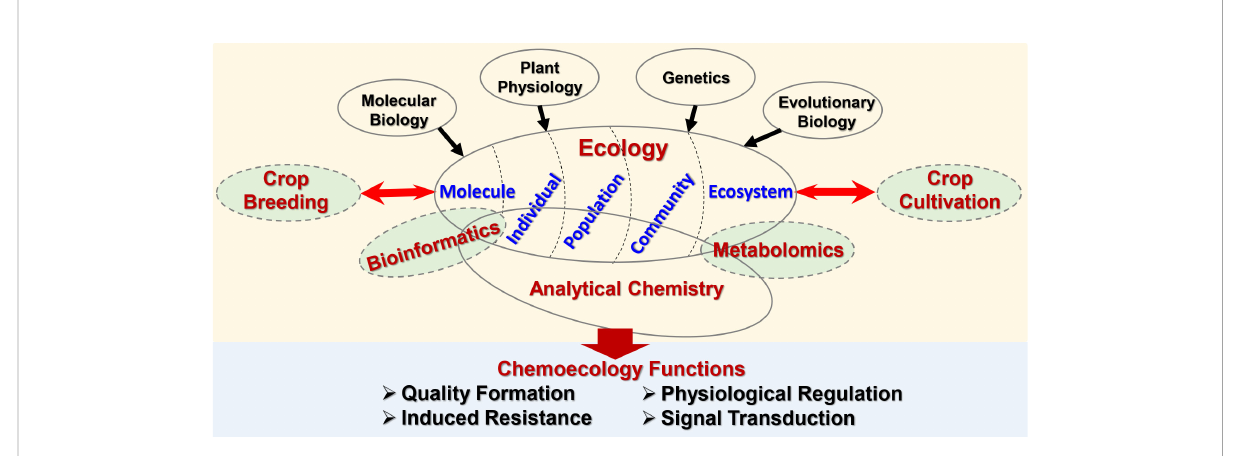
FIGURE 1 Cross amalgamation of contemporary